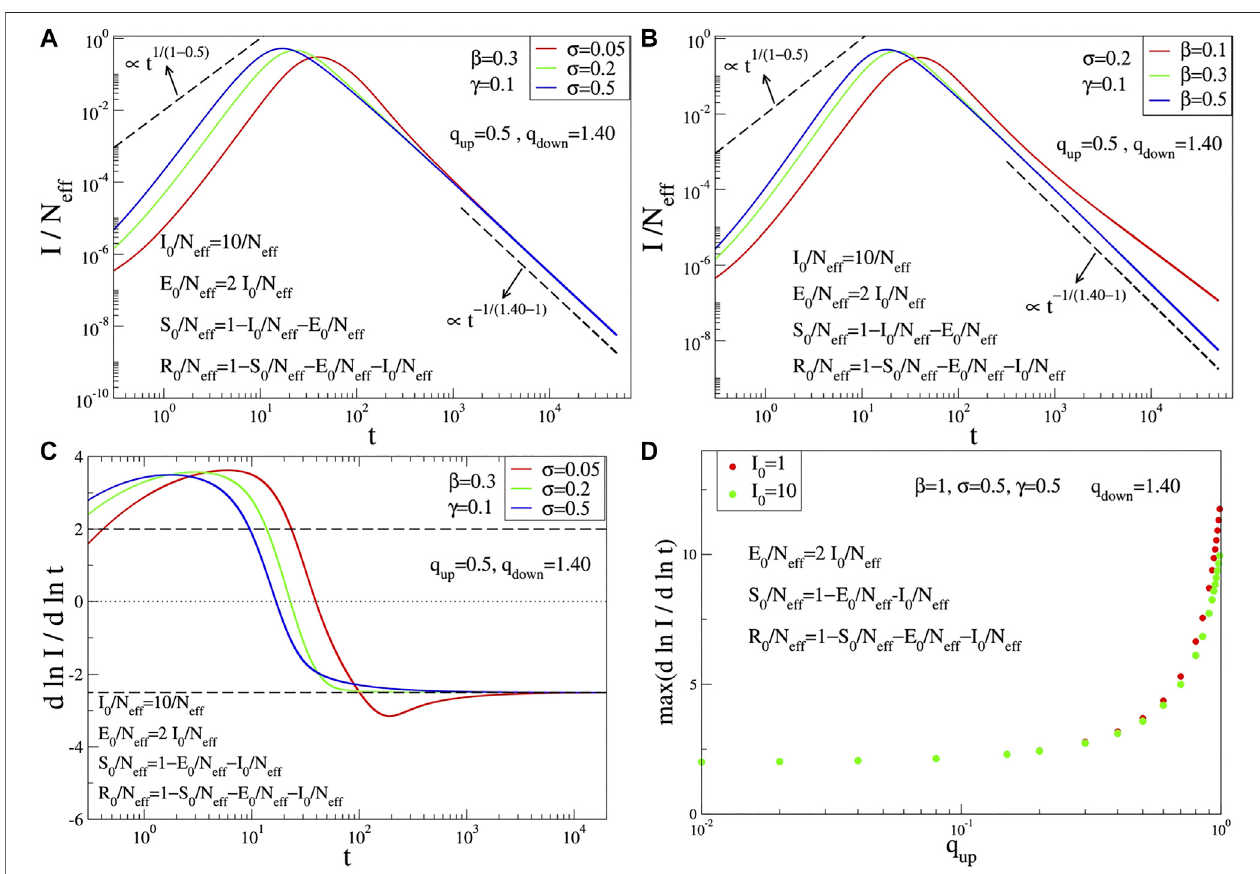
FIGURE 2 | Time evolution of I ( t ) for the q -SEIR equations with N eff (cid:2) 10 8 ; we consider t to run virtually from zero to in fi nity (not necessarily during only the typical range of real epidemics, say 1,000 days). (A) Fixed ( β , c ) and various values of σ . (B) Fixed ( σ , c ) and various values of β . (C) Time dependence of the slope of [ d ln I / d ln t ] , which, in contrast with the q -SIR equations, is not bounded between 1 / ( 1 − q ) > 0 and − 1 / ( q − 1 ) < 0 (dashed lines). The dotted line corresponds to up down the position of the peak of I ( t ) , and the maximum (minimum) corresponds to left (right) in fl ection points. (D) The maximal slope of I ( t ) / N eff as a function of q up . The high value at q up (cid:2) 1 re fl ects the divergence expected in the limit q up (cid:2) q down (cid:2) 1. Indeed, in this limit, the present q -SEIR model recovers the standard SEIR model, which increases exponentially (and not as a power-law) toward the corresponding peak. Notice also that this slope decreases when I 0 / N eff increases.